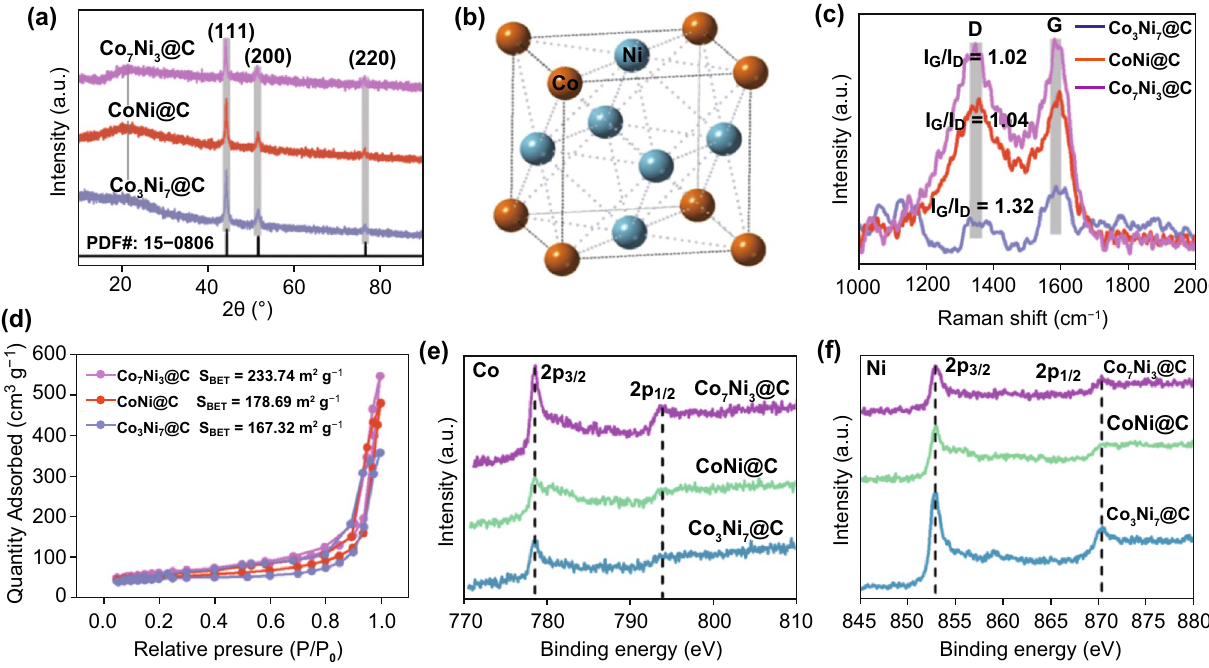
Fig. 2 a XRD pattern of Co x Ni y @C composites. b Atomic structure diagrams of CoNi. c Raman spectra of Co x Ni y @C composites. d Nitrogen adsorption–desorption isothermals of Co x Ni y @C composites. XPS spectra of CoNi@C e Co 2 p and f Ni 2